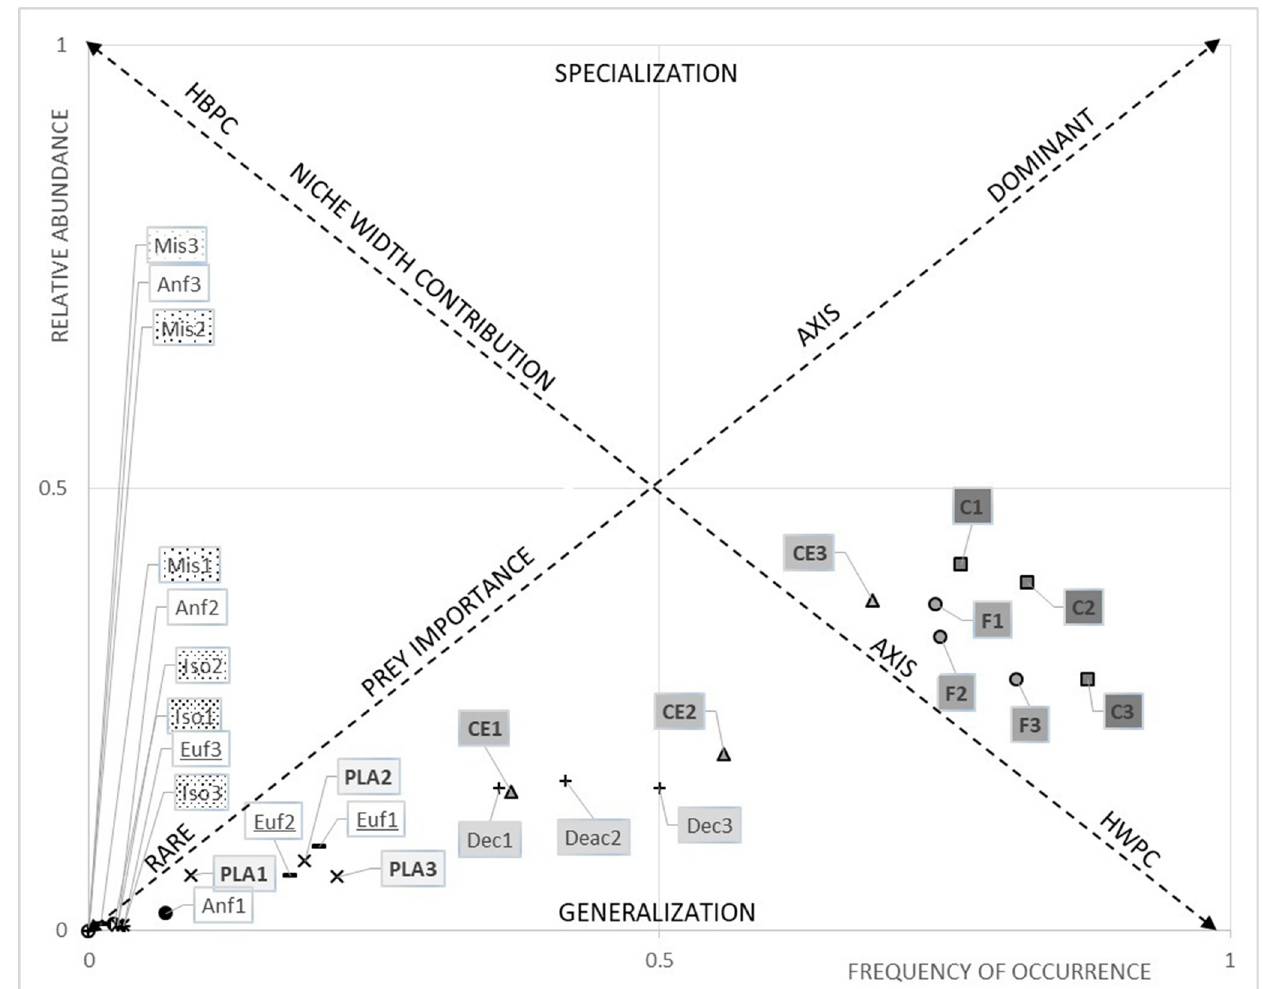
Figure 4. Costello’s diagram applied to prey composition found in the stomachs of a sample of the black mouth catshark Galeus melastomus from the bathyal plane of the central Tyrrhenian Sea. 1, 2 and 3 inside the data labels represent small, intermediate and large size classes and same labels ‘background denotes same prey category. C: total crustaceans, dark grey squares; F: bony fishes, dark grey circles; CE: cephalopods, dark grey triangles; MP: microplastics, asterisks. Dec: Decapoda, crosses; Euf: Euphasiacea, dashes; Anf: Anfipoda, dark squares; Mis: Misydacea, empty circles; Iso: Isopoda, empty triangles.